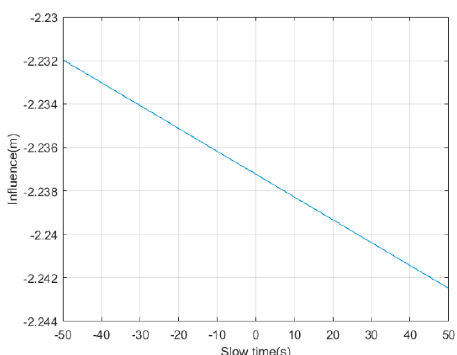
Figure A3. The influence of target motion on the relative motion caused by signal round-trip delay.